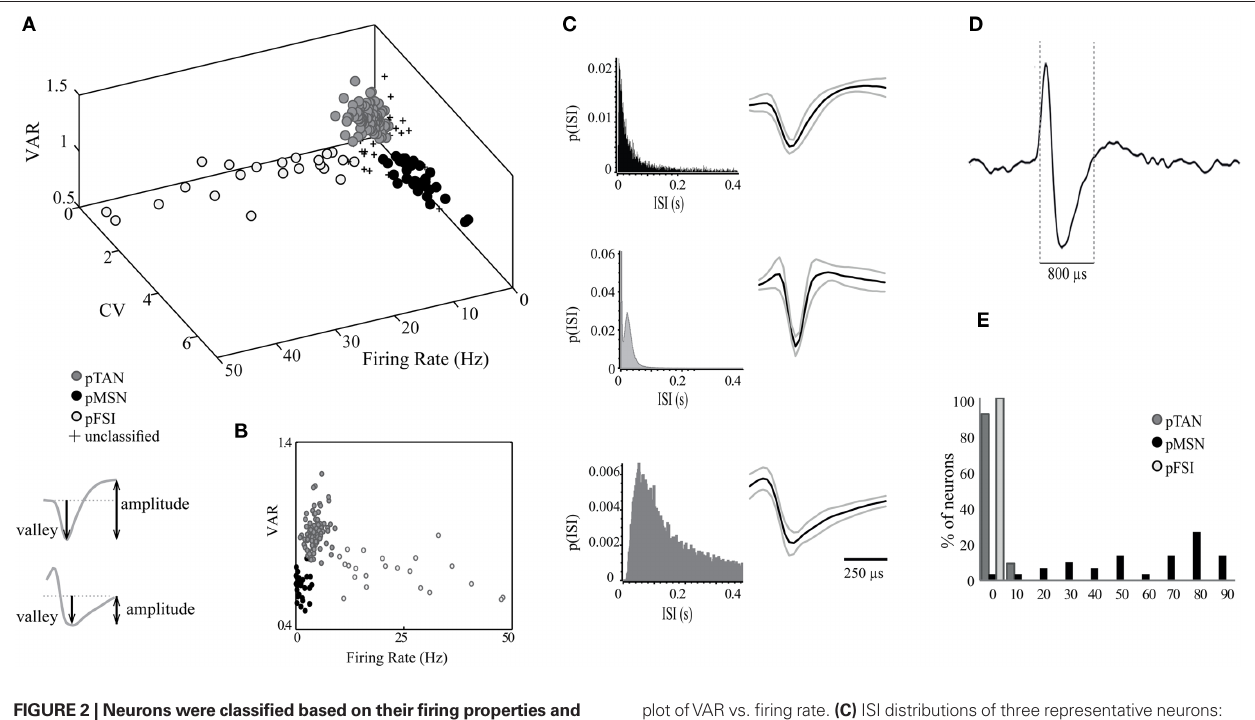
Figure 2 | Neurons were classified based on their firing properties and waveform shapes. (A) Scatter plot of firing rate, cv, and VAR showing the separation of the recorded neurons into three groups categorized as: pMSNs, pTANs, and pFSIs. The inset below the 3D plot demonstrates how the valley amplitude and the valley to following peak amplitude were measured. (B) A 2D